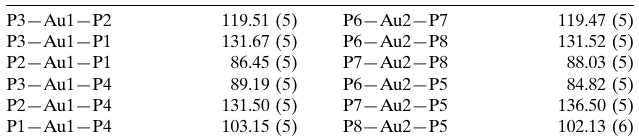
Selected bond angles ( (cid:2)